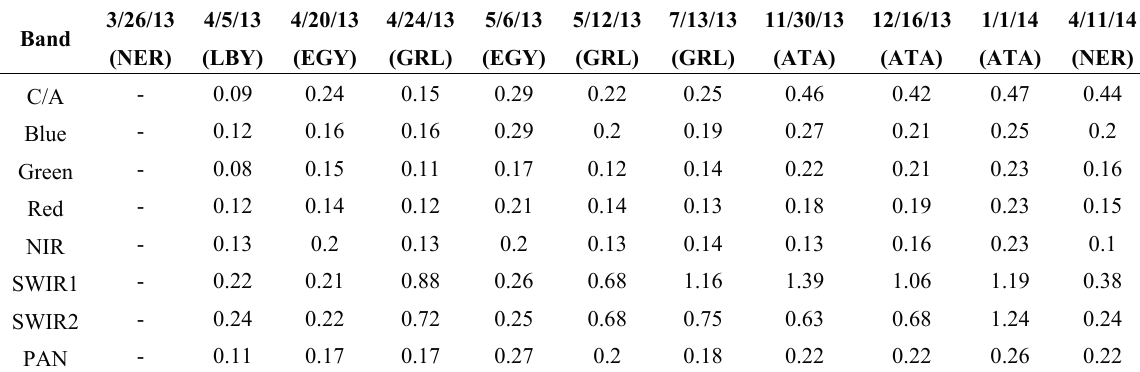
Table 4. Maximum relative gain percent differences obtained from side-slither collects as a function of time during the first year of OLI